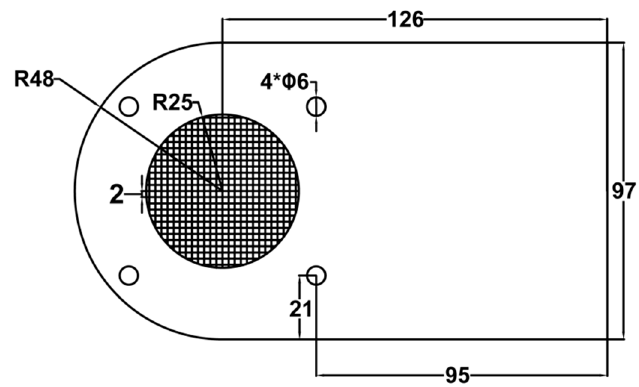
Figure 4. Flange mounted wire-mesh probe (dimensions in mm).